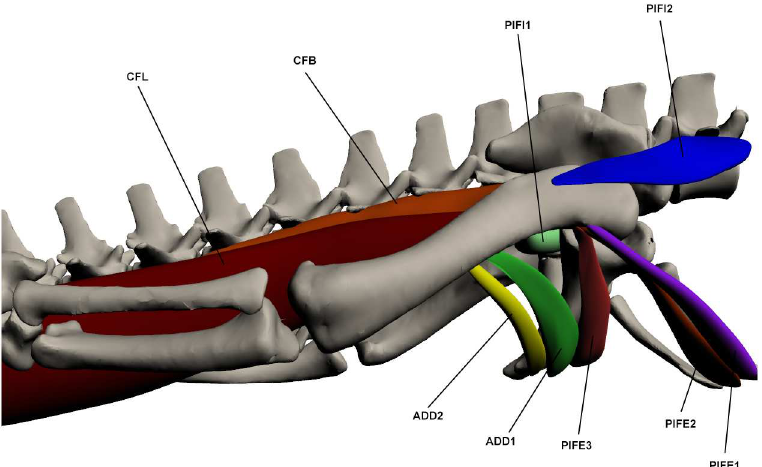
Fig 16. Deep ventral muscles of the upper hindlimb. CFL: Caudofemoralis longus ,CFB: Caudofemoralis brevis , PIFI1-2: Pubo-ischio-femoralis internus 1–2 , ADD 1–2: Adductor 1–2 , PIFE 2–3: Pubo-ischio- femoralis externus 2–3